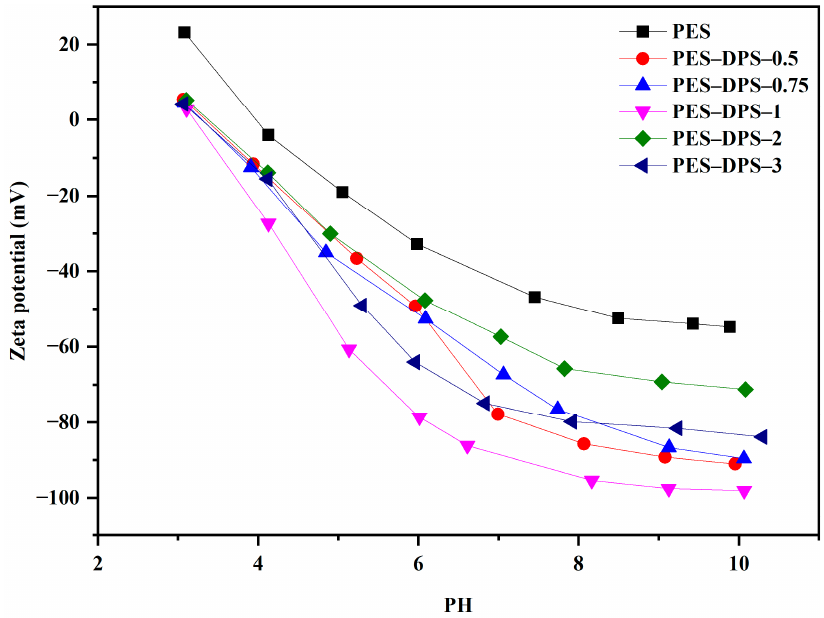
Figure 7. Zeta potentials of loose TFC NF membranes and PES membrane.